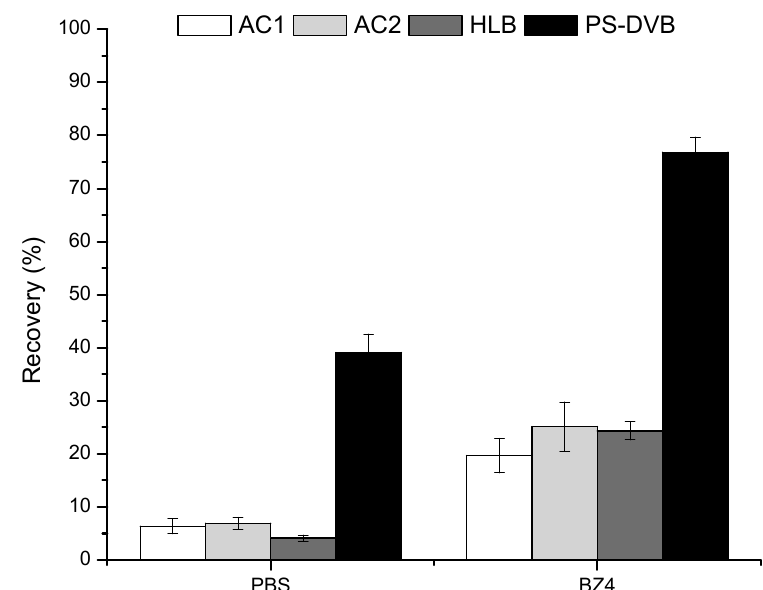
Figure 1. Average extraction e ffi ciency obtained by BA µ E- µ LD / HPLC–DAD using di ff erent activated carbons and polymers sorbent phases for the microextraction of PBS and BZ4 in ultra-pure water, using standard experimental conditions. The error bars represent the standard deviation of 3